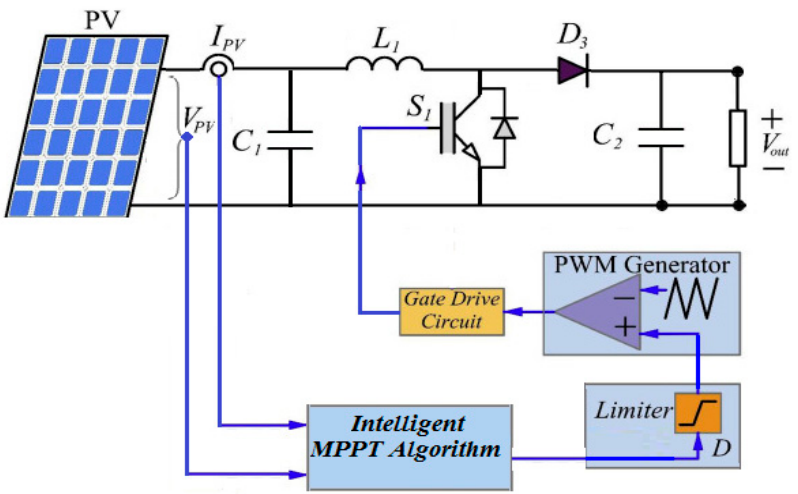
Figure 4. Block diagram of a PV system using an intelligent MPPT algorithm.